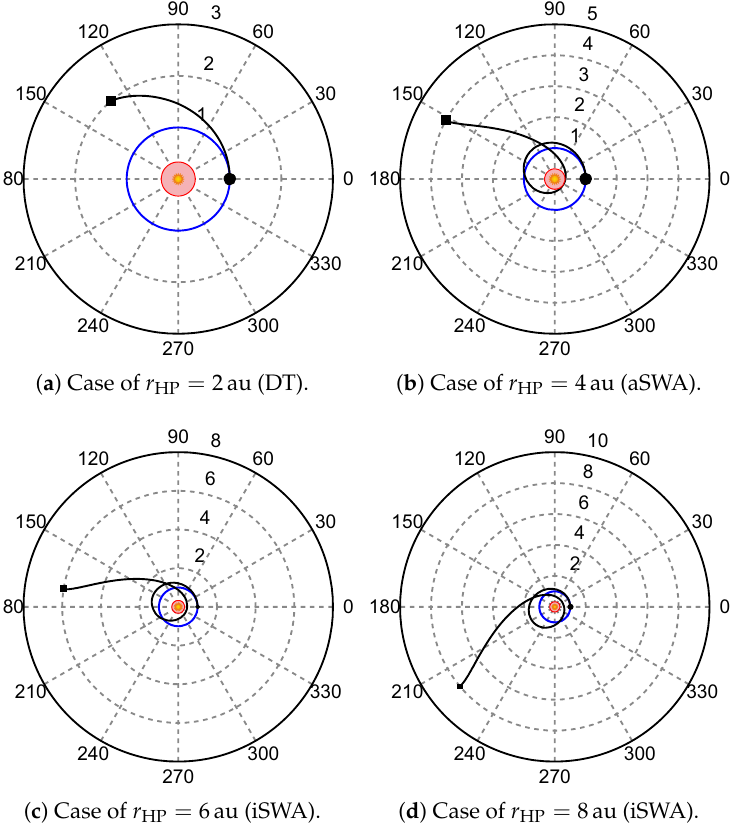
Figure 8. Optimal transfer trajectories in a two-dimensional mission scenario when r HP ∈ { 2,4,6,8 } au. The radial distance is in astronomical units, black circle → start, and black square → arrival/equilibrium